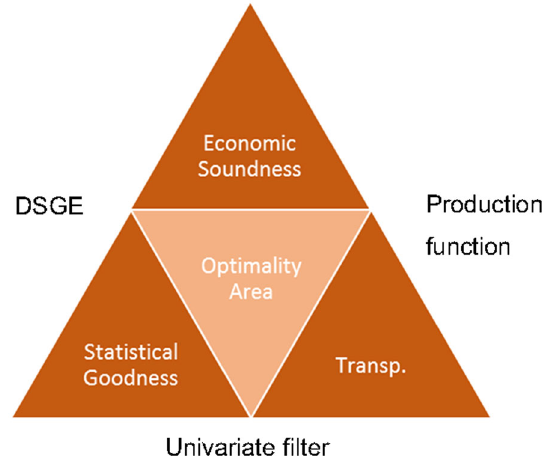
Fig. 1 Optimality necessary